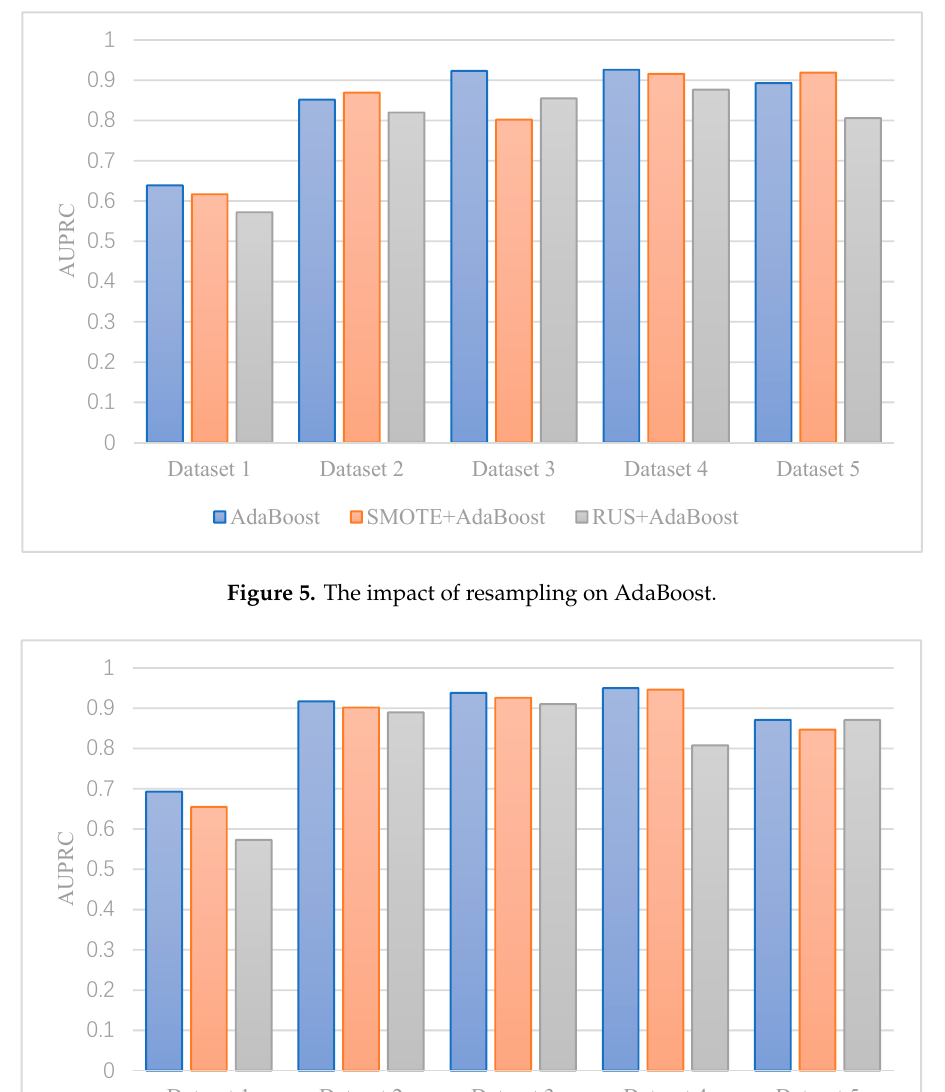
Figure 4. The impact of imbalance ratio on AdaBoost.